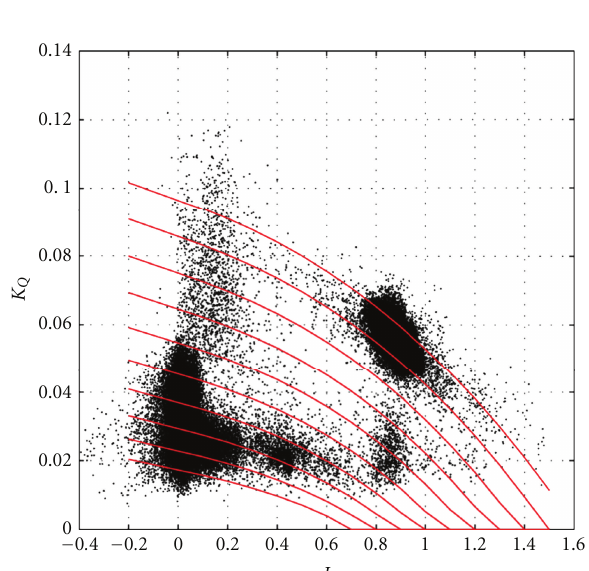
Figure 3: Time series of the training set.